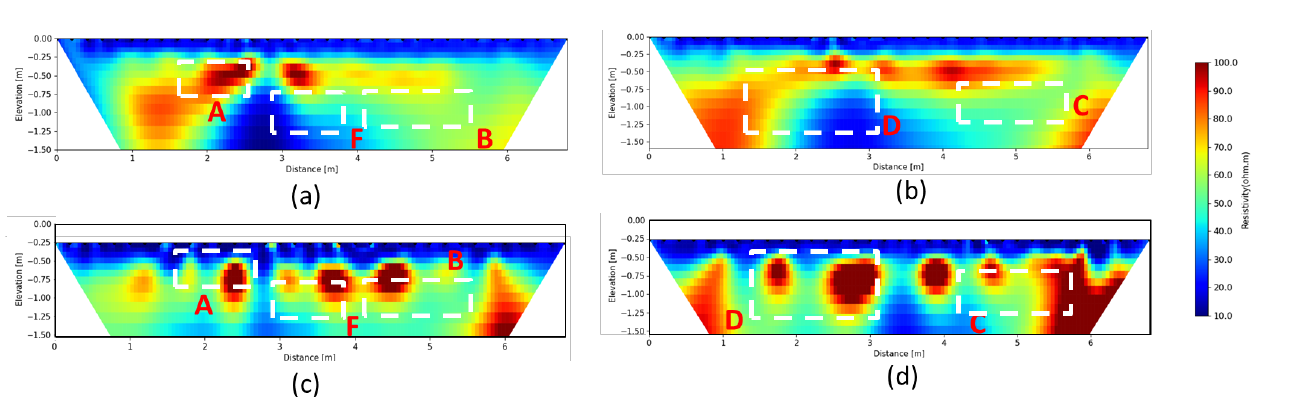
Figure 14. 2D ERTs obtained on S1 and S2 with floating ( a , b ) and underwater ( c , d ) electrodes using the dipole – dipole Array (the inversions are performed with ResIPy).